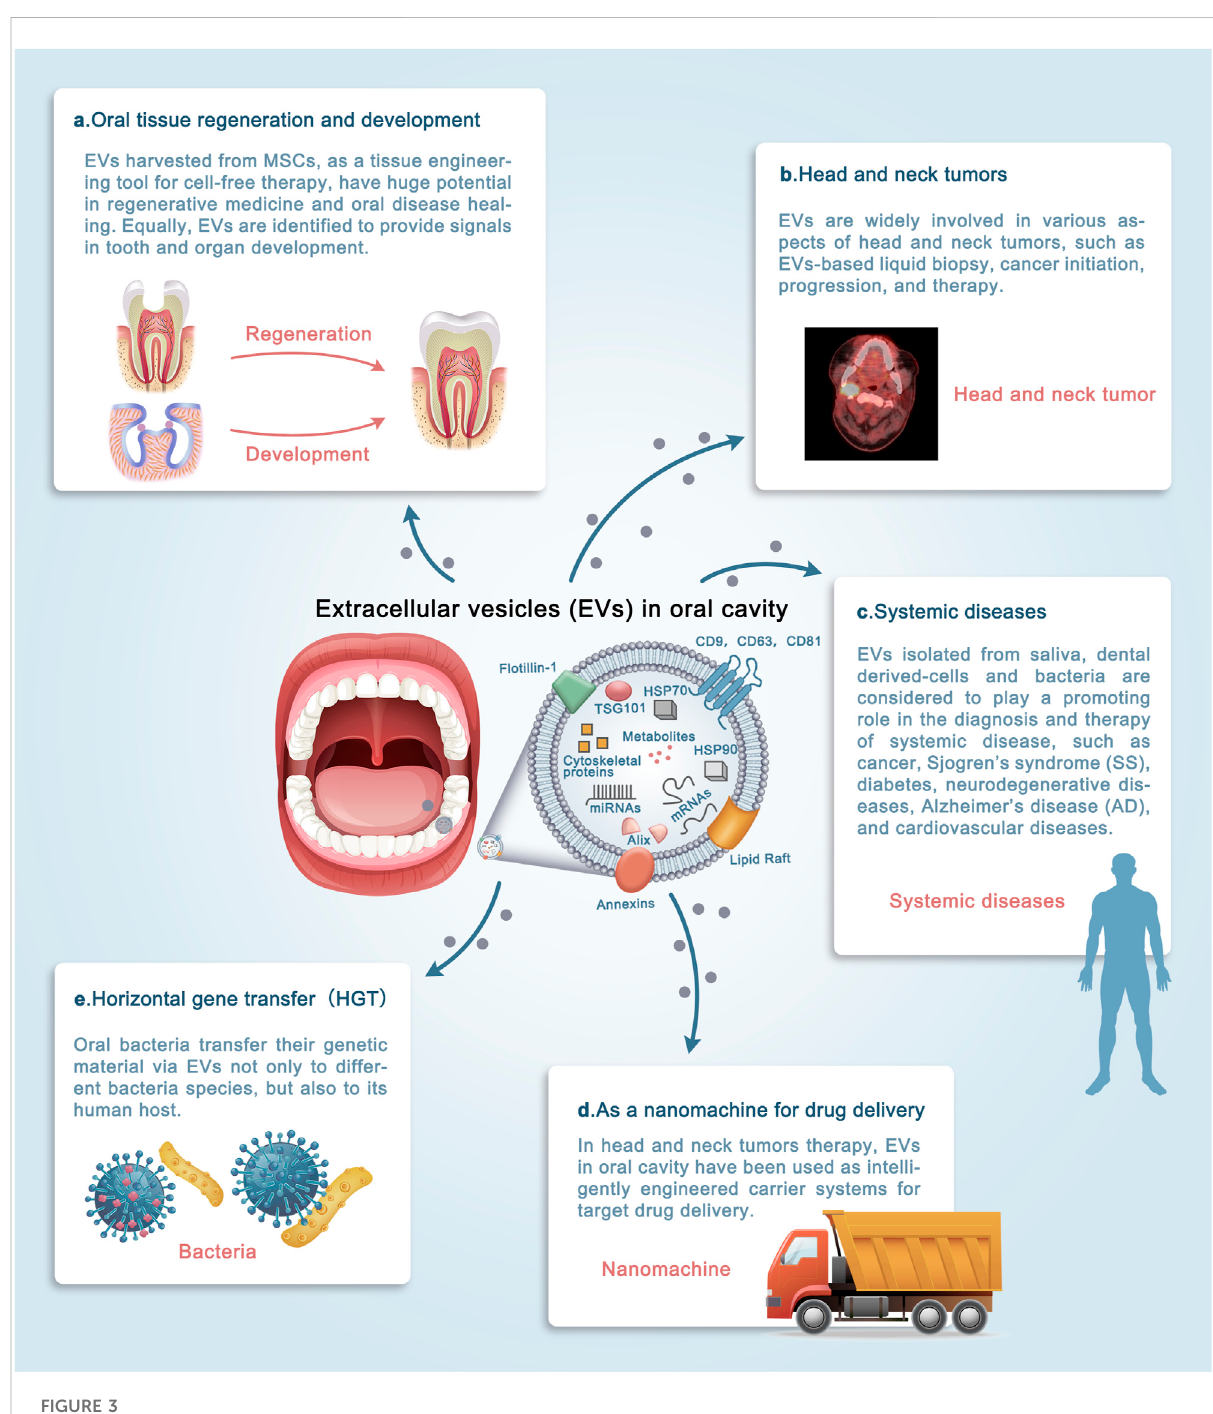
The roles of extracellular vesicles (EVs) in the oral cavity. The diverse sources of EVs in the oral cavity have allowed their involvement in a wide variety of physiological and pathological processes. (A – E) Schematic illustrating the promising clinical applications by which EVs may contribute to the diagnosis and treatment of diseases. Evidence supporting these applications is discussed in detail in the text. Note that EVs exert their function mainly in three ways: 1. source of EVs; 2. microenvironment in which EVs parent cells are located; 3. engineering of bilayer membrane vesicles structure. It isincreasingly apparent that theclinicalapplications ofEVs intheoral cavity are widespread,and theunderlying signalingnetwork needs to be deciphered. (MSCs: Mesenchymal stem